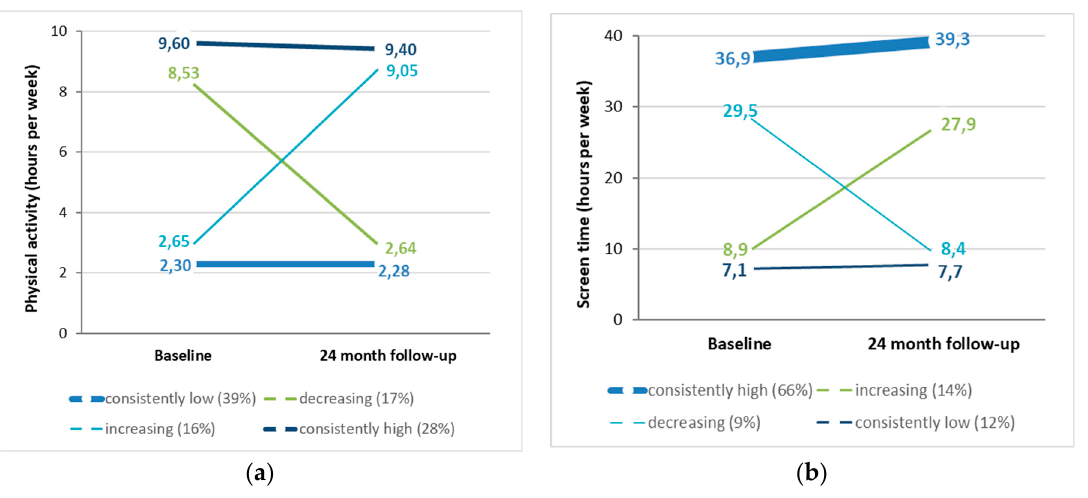
Figure 1. Trajectories (mean hours per week) among 7th grade to 9th grade students for ( a ) physical activity and ( b ) screen time (lines’ weights reflect size of trajectories).